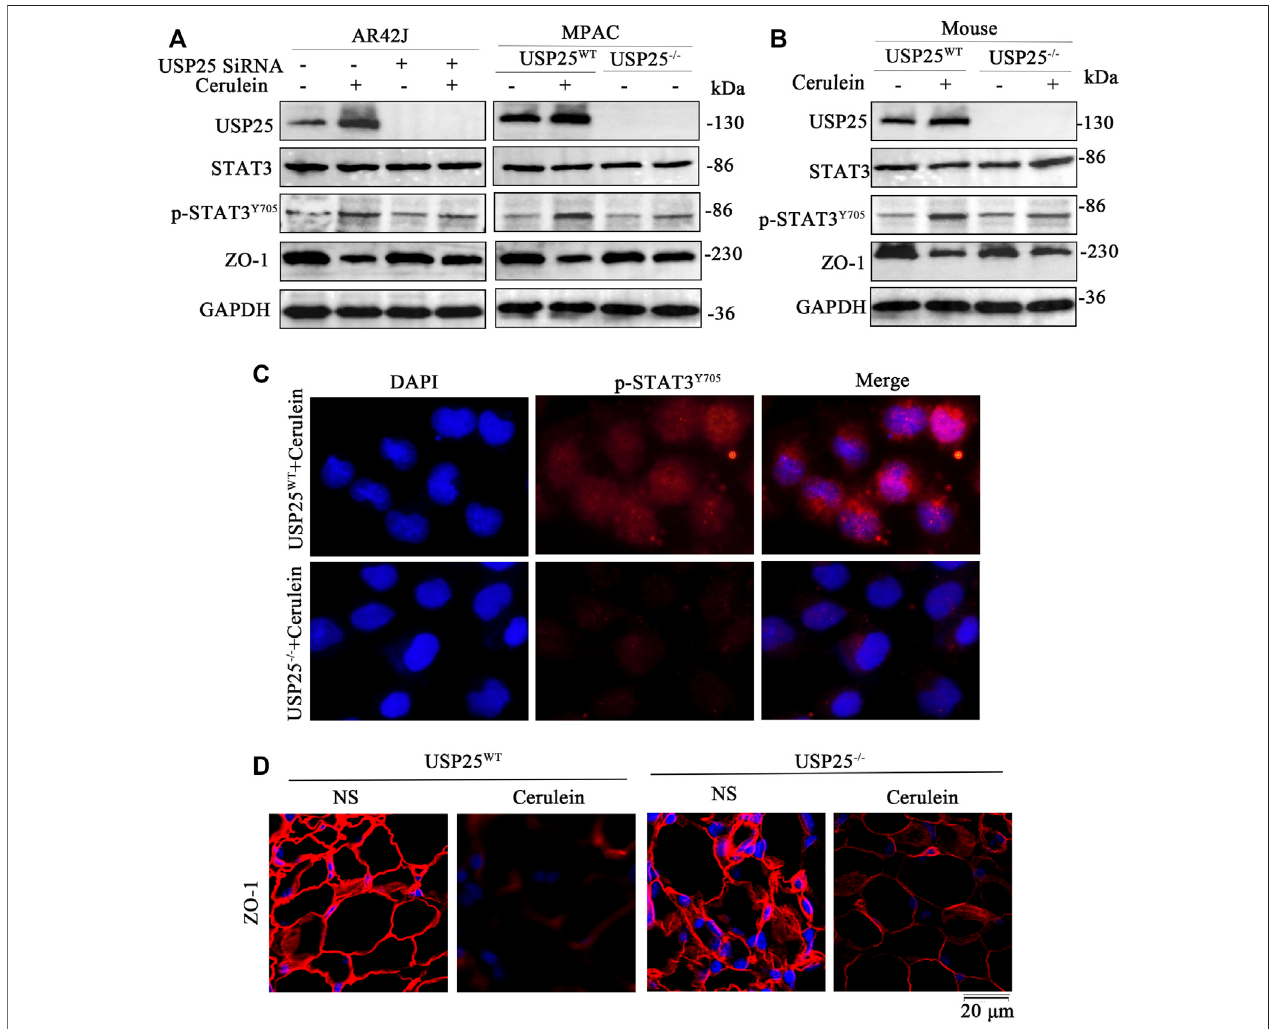
FIGURE 5 | USP25 exacerbates acute pancreatitis by destroying tight junctions of the pancreas and STAT3 activation may be involved in vitro and in vivo . (A) WesternblottingwasusedtomeasuretheproteinlevelsofUSP25,STAT3,p-STAT3Y705andZO-1proteininAR42J,MPACcellstransferredwithnontargetingSiRNAs (NC) or USP25 SiRNA and induced AP with cerulein. (B) Western blotting was performed to measure the protein levels of USP25, STAT3, p-STAT3Y705, and ZO-1 in mice pancreases of the following four groups: USP25WT + NS, USP25WT + cerulein, USP25 − / − + NS, USP25 − / − + cerulein (C) The expression level of p-STAT3Y705 were examined by immuno fl uorescence in MPAC of two groups: USP25WT + cerulein and USP25 − / − + cerulein (D) ZO-1 were examined by immuno fl uorescence in mice pancreases of four groups: USP25WT + NS, USP25WT + cerulein, USP25 − / − + NS, USP25 − / − + cerulein mice.